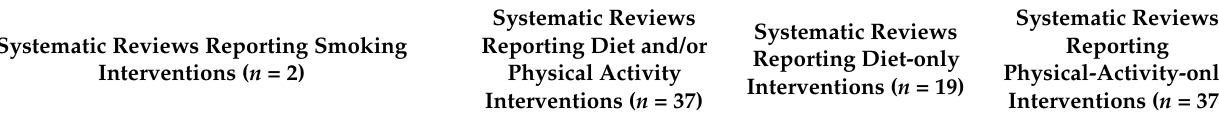
Table 1. Summary data for included systematic